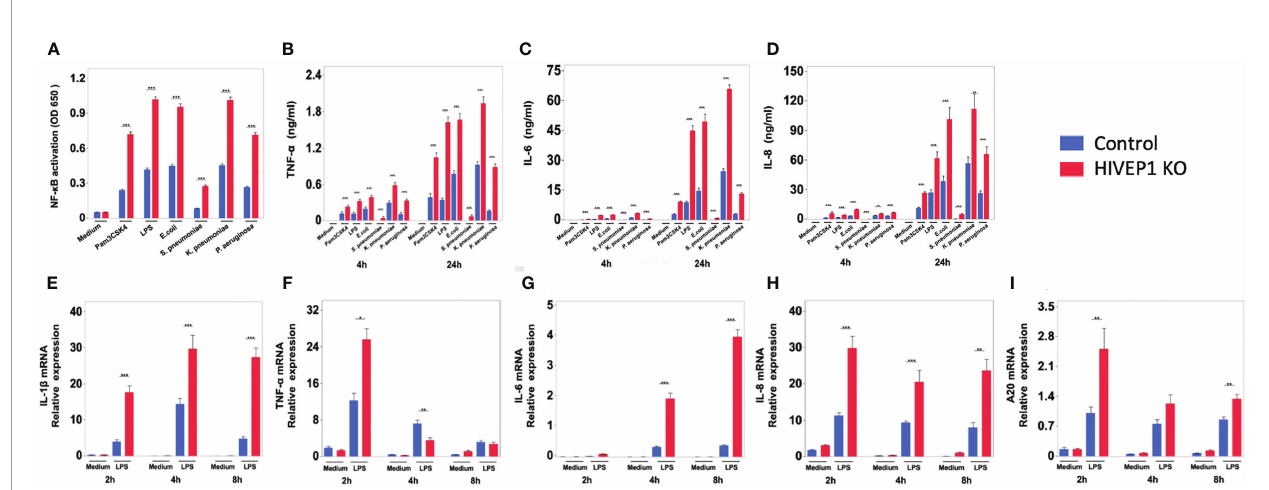
FIGURE 3 | HIVEP1 de fi cient human monocytic cells show increased NF k B activity and proin fl ammatory cytokine production upon stimulation with TLR ligands or bacteria. HIVEP1 de fi cient and control human monocytic THP1-MD2-CD14 cells were stimulated with PAM3CSK4 (1 µg/mL), LPS (100 ng/mL), heat-killed E . coli , S. pneumoniae , K . pneumoniae or P. aeruginosa. HIVEP1 de fi ciency was associated with (A) enhanced NF k B activity (24-hour stimulation), (B – D) enhanced TNF- a , IL-6 and IL-8 release (4 and 24 hour stimulation) and (E – I) increased IL-1 b , TNF- a , IL-6, IL-8 and A20 mRNA expression (normalized to HPRT mRNA). Data shows means ± SEM and were pooled from two (E – I) and three (A – D) independent data set (n = 4 for each condition within each experiment). *P < 0.05, **P < 0.01, ***P < 0.001.